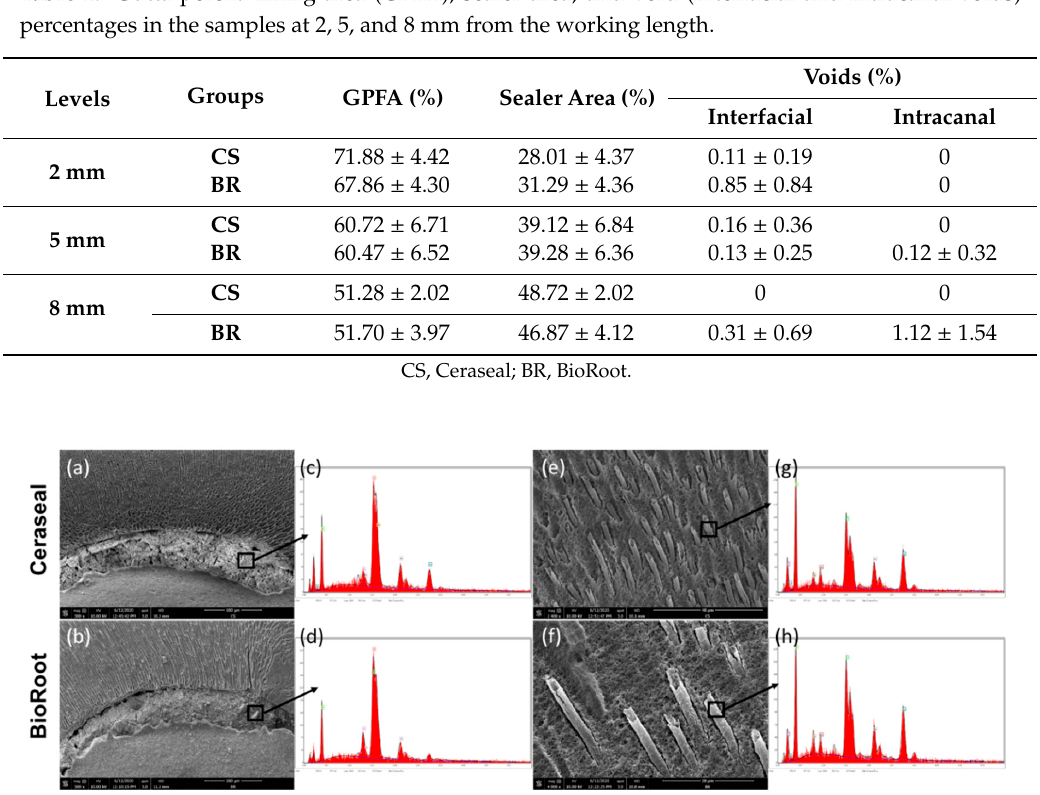
Figure 3. Representative photos of scanning electron microscopy of sectioned root surfaces filled with ( a , c , e , g ) Ceraseal and ( b , d , f , h ) BioRoot. ( a , b ) Sealer–dentin interface; ( e , f ) infiltrations into dentinal tubules; ( c , d ) chemical analysis of the sealer in root canal; ( g , h ) chemical analysis of the infiltrations into dentinal tubules.